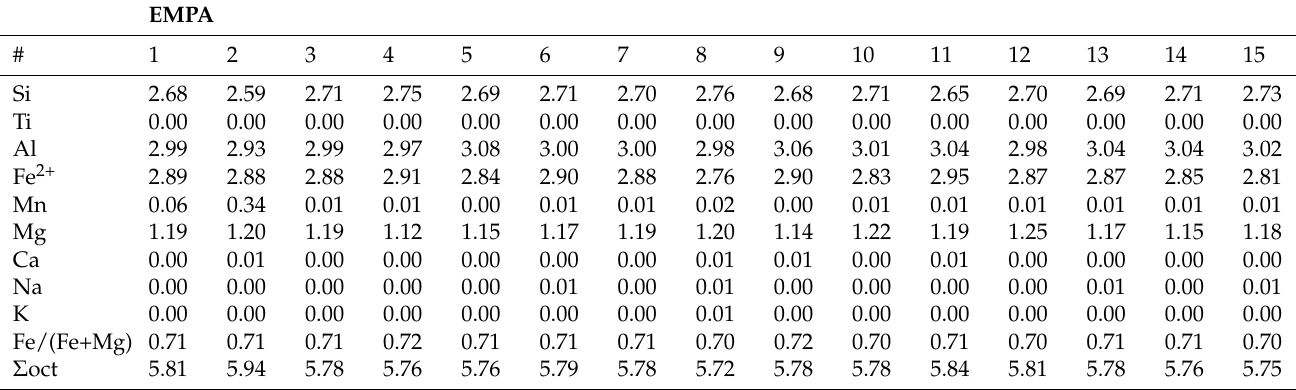
Table 1. EMPA, SEM-EDX and TEM-EDX analyses of Fe-chlorite vein . Apfu; 14 oxygen basis. * analysis with 7Å layers.